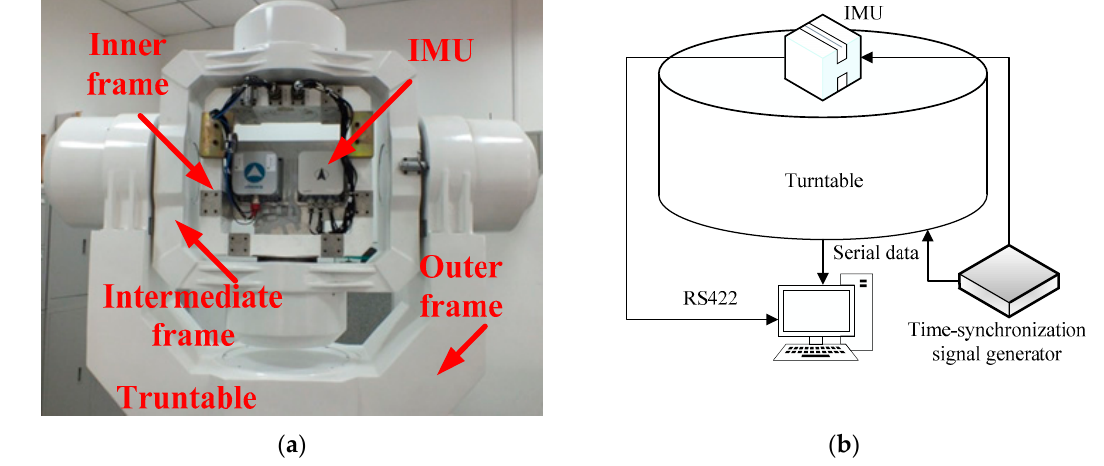
Table 6. The statistics of the alignment errors ( ◦ ).